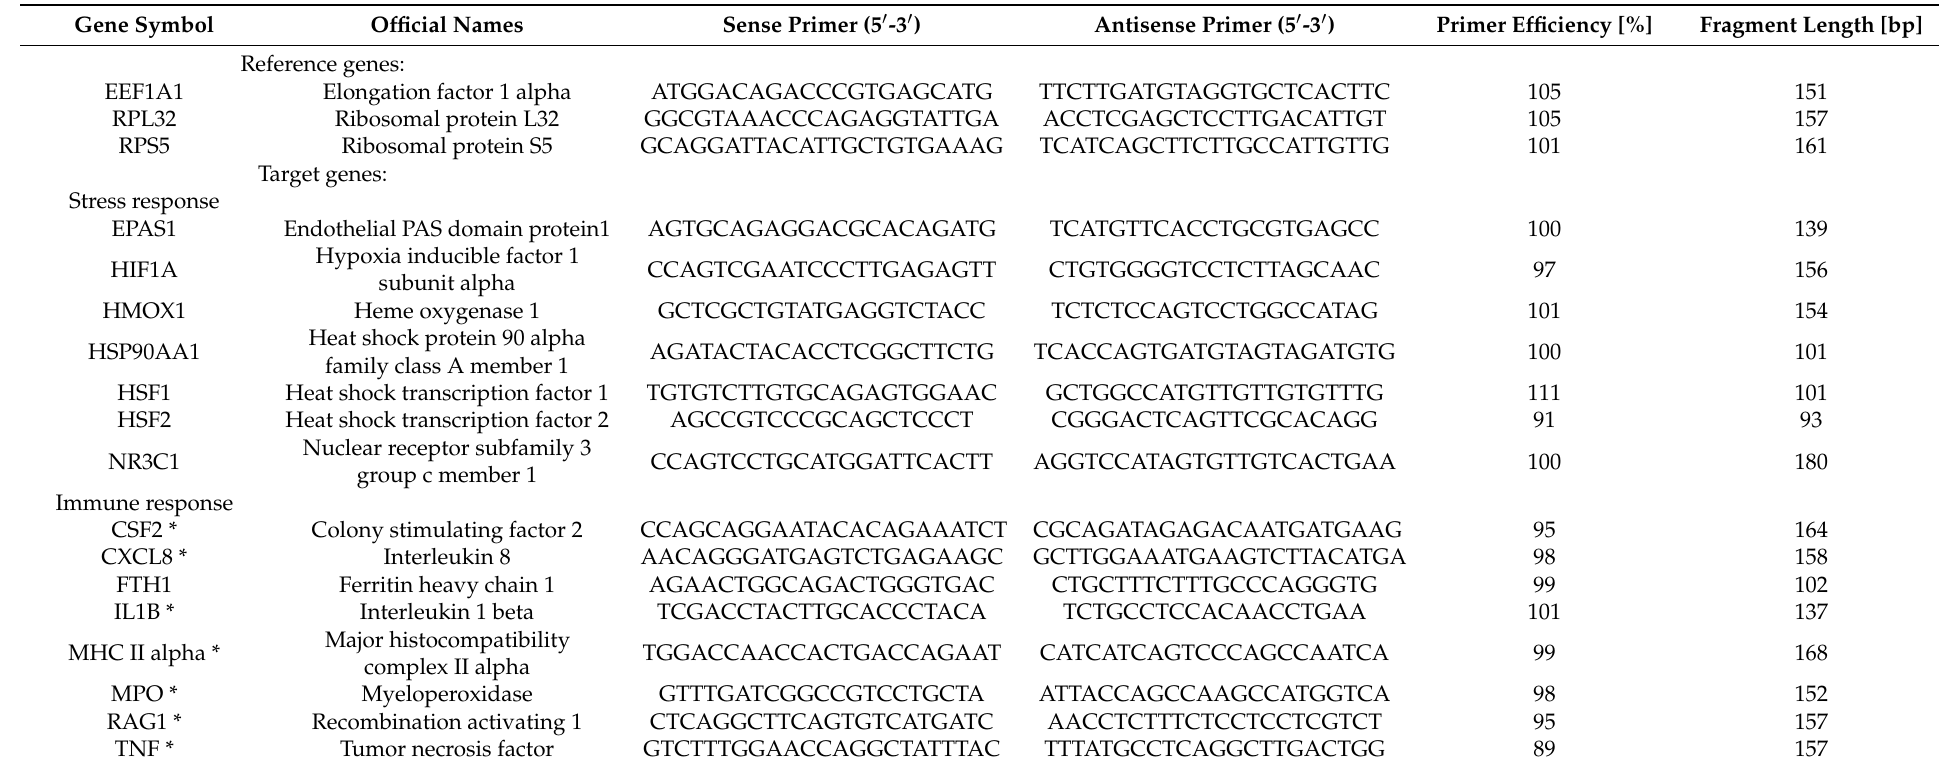
Table 1. Gene-specific primers used in this